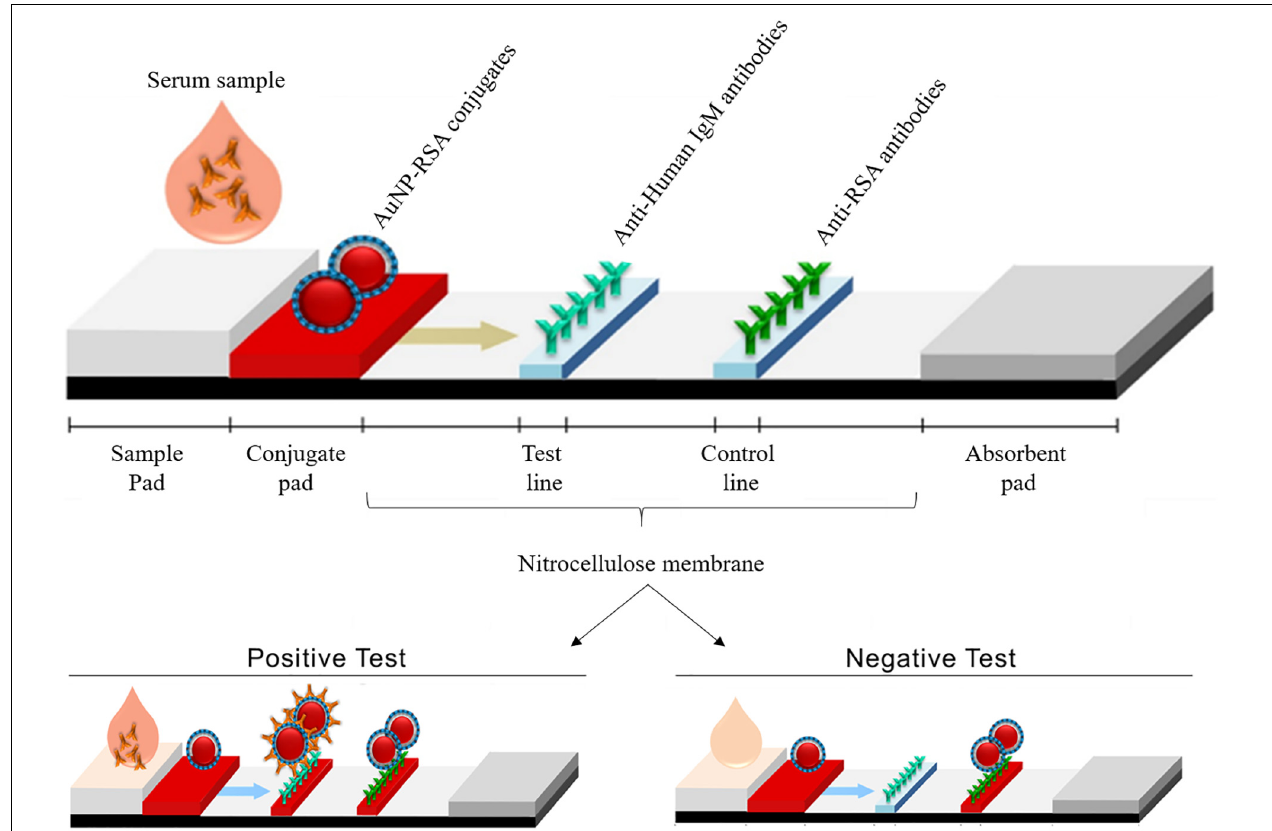
FIGURE 1 | Illustration of LFIA strips developed in this study, showing its various components and the expected results in positive and negative tests. In a positive test, AuNP-RSA conjugates will bind to IgM anti- P. jirovecii antibodies present in the serum of infected patients, forming a complex that is captured by the immobilized anti-human IgM in the test line that becomes red colored. AuNP-RSA conjugates in excess will continue to migrate from the test line to the control line, where immobilized anti-RSA antibodies will capture them, giving rise to a second red line. In the negative test, as IgM anti- P. jirovecii antibodies are absent in the patient’s serum, no complex is formed with AuNP-RSA conjugates, which precludes the interaction with anti-human IgM antibodies, preventing the color formation at the test line (no color). In the control line, the AuNP-RSA conjugates will be captured by the immobilized anti-RSA antibodies, giving rise to a red